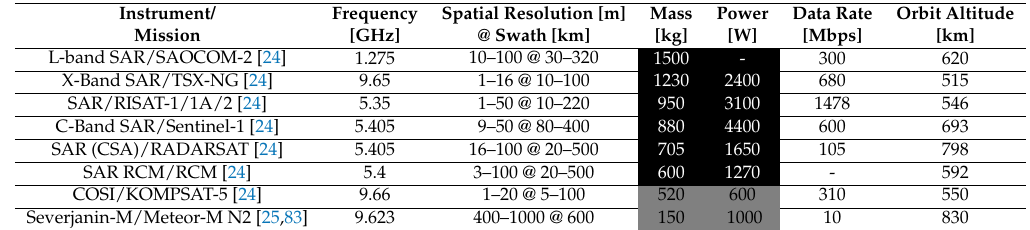
Table A13. Survey of SAR imager